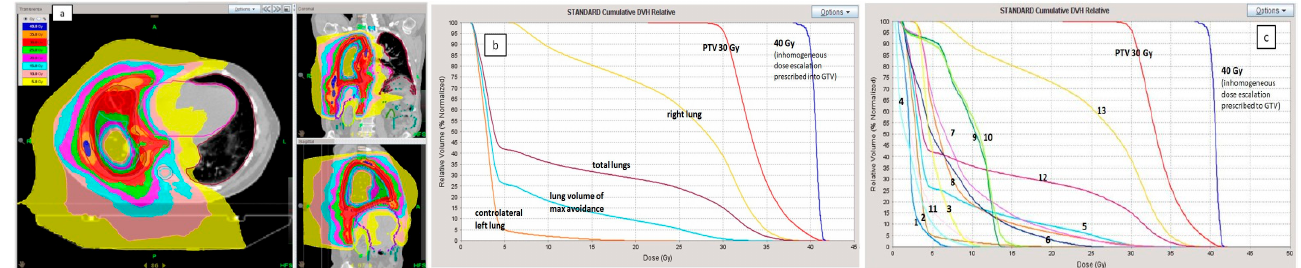
Figure 1. ( a ) Example of dose distribution of a patient plan treated in November 2017 for right MPM.The patient underwent 3 cycles of CHT and no surgery procedures except for biopsy. Prescription dose was 30 Gy in 5 daily fractions with inhomogeneous dose escalation up to 40 Gy inside the Gross Tumor Volume. Patient deceased 4 months after the treatment for disease complications. ( b ) dose-volume histogram in the same patient. underlining the absorbed doses by the different lung volumes. Prescribed dose was 30 Gy to the entire pleura with 40 Gy inhomogeneous dose escalation up to 40 Gy in the Gross Tumor Volume (GTV). The figure of dose distribution is reported in the paper. ( c ) dose-volume histogram in the same patient. 1: left kidney. 2: left lung (contralateral). 3: stomach. 4: bowel. 5: lung volume of max avoidance. 6: right kidney. 7: